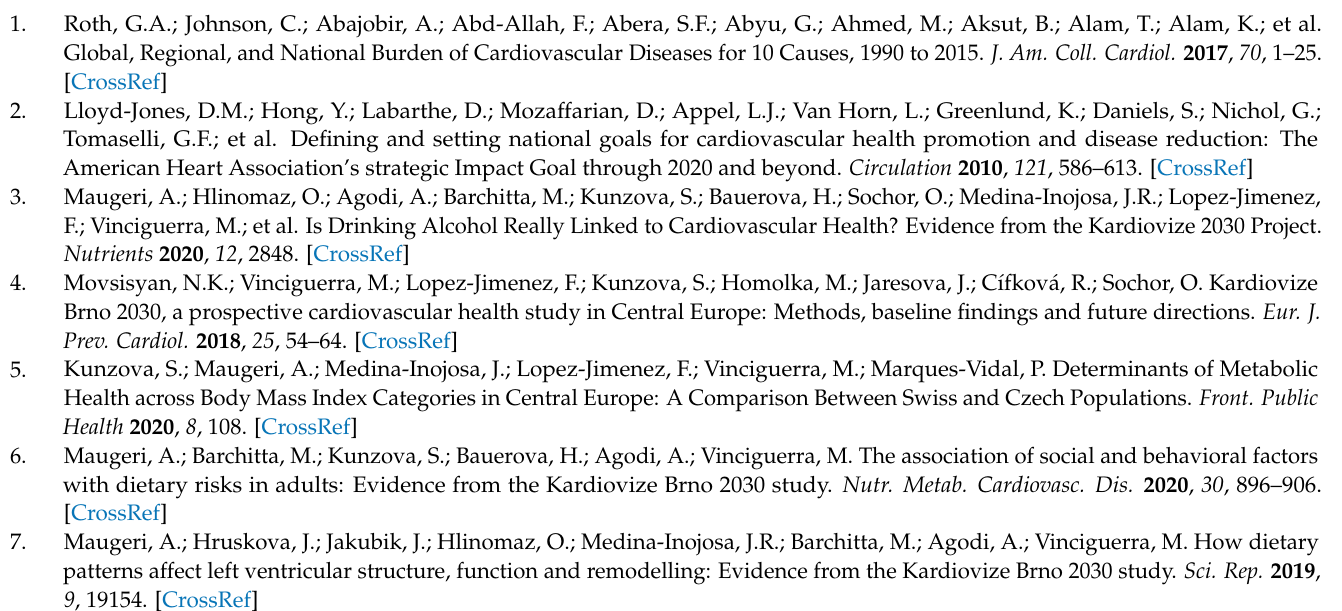
Lipid species with adjusted p -value (FDR) <0.05 are indicated in red., Figure S6: ANOVA analysis of lipid species across CVH categories of blood fasting glucose. Lipid species with adjusted p -value (FDR) <0.05 are indicated in red., Figure S7: ANOVA analysis of lipid species across categories of CVH. Lipid species with adjusted p -value (FDR) <0.05 are indicated in red., Figure S8: Classification performance and permutation test of the PLS-DA. ( A ) PLS-DA classification using different number of components. The red star indicates the best classifier. ( B ) PLS-DA model validation by permutation tests based on separation